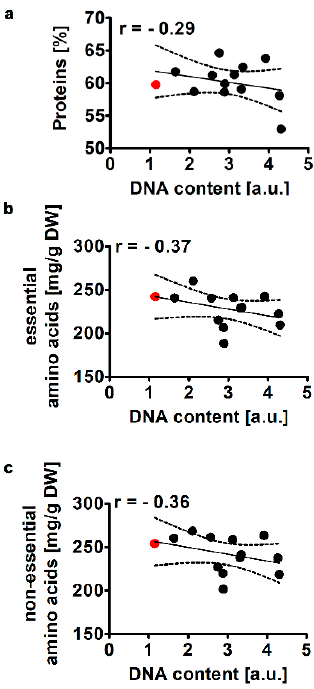
Figure 3. Colchicine and cytochalasin B-mediated effect on the levels of proteins ( a ), essential amino acids ( b ) and non-essential amino acids ( c ) in the microalga Planktochlorella nurekis . Correlation analysis between protein levels ( a ), essential amino acids ( b ), non-essential amino acids ( c ) and DNA content. Twelve CC-treated clones were considered (black dots). WT cells are denoted as a red dot. Results represent the mean from three independent experiments. The levels of amino acids [mg] were calculated per g of dry weight. The 95% confidence interval is shown. Correlation analysis of the data was performed using a Linear Correlation (Pearson r) test.